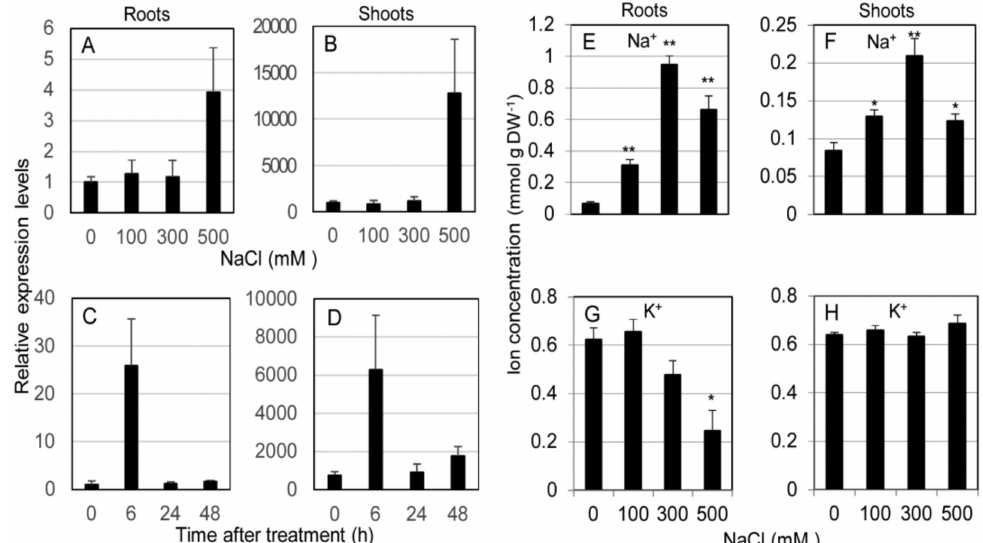
Figure 2. Expression profile of SvHKT1;1 gene and Na + concentrations in Sporobolus virginicus under salt stress. The expression profile of SvHKT1;1 gene and Na + concentrations in roots and shoots of hydroponically grown S. virginicus were determined. ( A – D ) Expression levels of SvHKT1;1 gene determined by qRT-PCR under di ff erent NaCl concentrations ( A , B ) or at di ff erent time points after salt treatment ( C , D ). Plants grown in 1 / 2 Murashige and Skoog (MS) medium were transferred to 1 / 2 MS medium supplemented with 0, 100, 300, or 500 mM NaCl, and the roots ( A ) and shoots ( B ) were harvested at 48 h after the treatment. Plants grown in 1 / 2 MS medium were transferred to 1 / 2 MS medium supplemented with 500 mM NaCl, and the roots ( C ) and shoots ( D ) were harvested at indicated time points. Expression levels relative to that in roots at 0 h after treatment (1.0) are shown. eIF3 was used as a reference gene. ( E – H ) Na + ( E , F ) and K + ( G , H ) concentrations in roots ( E , G ) and shoots ( F , H ) of hydroponically grown S. virginicus under di ff erent NaCl concentrations. The roots and shoots were harvested at 48 h after the treatment. Data are presented as means ± SE ( n = 3 biological replicates). Single and double asterisks denote significant di ff erences compared with the values of WT plants of the same conditions at p < 0.05 and p < 0.01, respectively, determined using the Student’s t